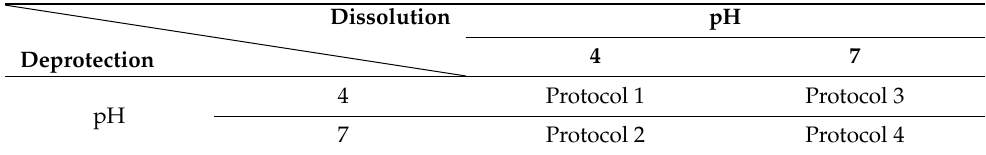
Table 1. Different pH in the molar ratio deprotection